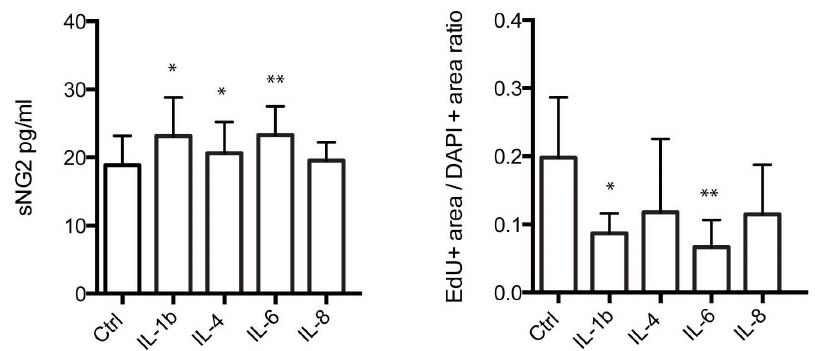
Figure 4. Proliferation and supernatant sNG2 levels of cultured human NG2 cells after exposure cytokines. The left bar graph shown the significantly increased sNG2 levels found in cell culture supernatant after 24 h stimulation with interleukin (IL)-1 b (0.3 ng/ml), IL-6 (1.5 ng/ml) and IL-4 (150 pg/ml). The sNG2 levels were not altered in response to 20 ng/ml IL-8. The right bar graph demonstrates the significantly decreased EdU + cell area to DAPI cell area ratio after exposure to IL-1b and IL-6, but not after IL-8 or IL-4. * indicates a significant difference at p , 0.05 level, ** indicates a significant difference at p , 0.01 level.